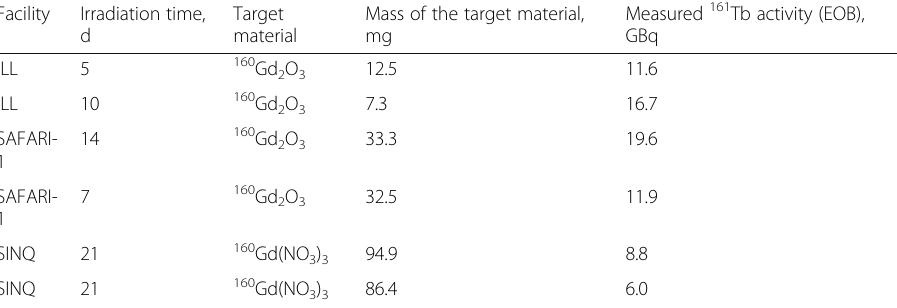
Table 2 Production yields of several 161 Tb batches, obtained from the irradiation facilities Facility Irradiation time, Target Mass of the target material, d material mg